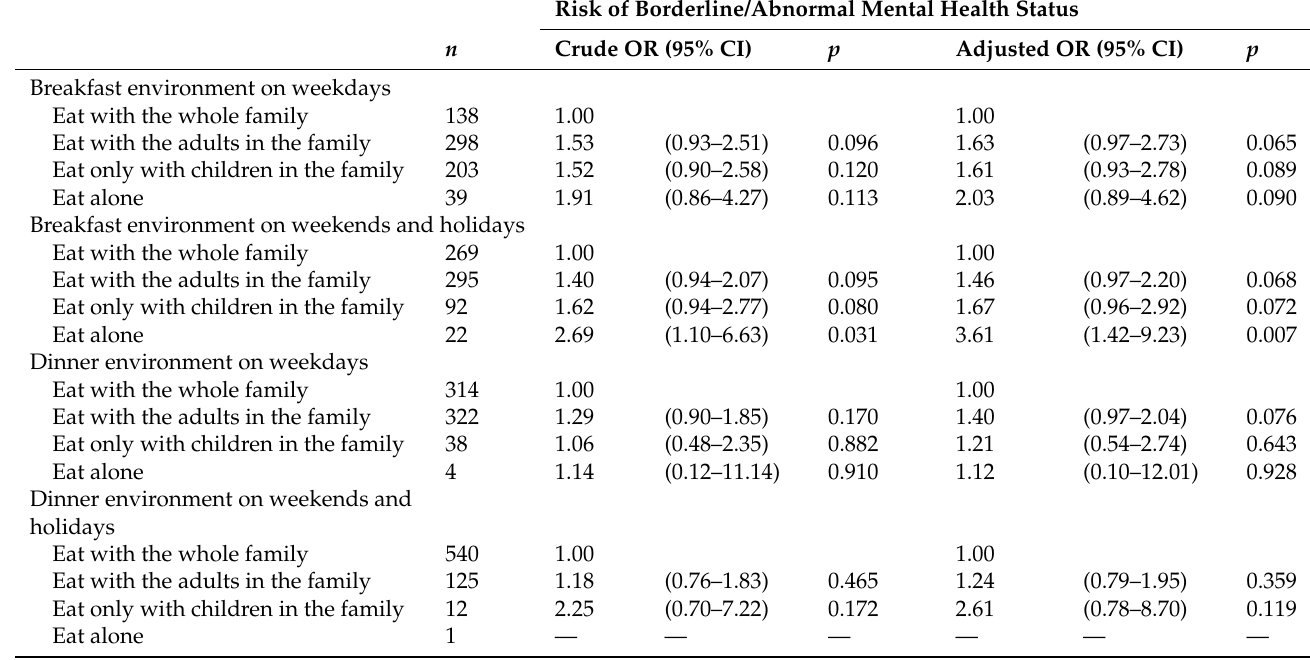
Table 4. Relationship of mealtime environment and prevalence of borderline/abnormal mental health status assessed by the Strengths and Difficulties Questionnaire among Japanese elementary schoolchildren (N =